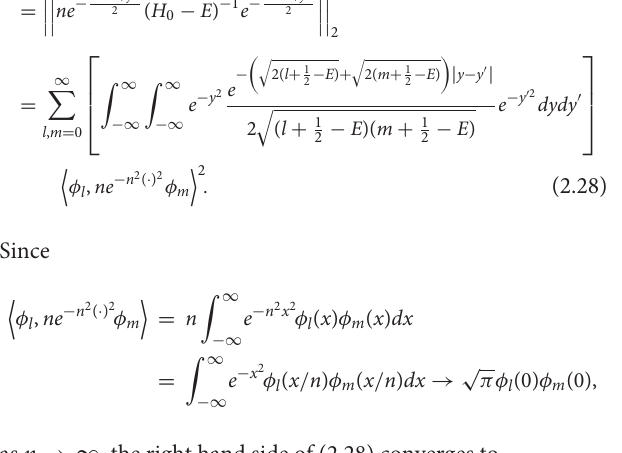
FIGURE 2 | A plot of the lower bound of the energy E as a function of λ resulting from the solution of Equation (2.22) (blue curve), the approximate expression valid for large values of E and λ obtained in (2.29) (yellow curve) and the approximation for small values of λ as in (2.30) (green curve). In the inset we have enlarged the region where λ and E are small. While the similarity between the solution of (2.22) and the funtion (2.29) is quite acceptable for a wide range of the parameters, the solution of (2.22) is satisfactorily approximated by (2.30) only for very small values of λ .